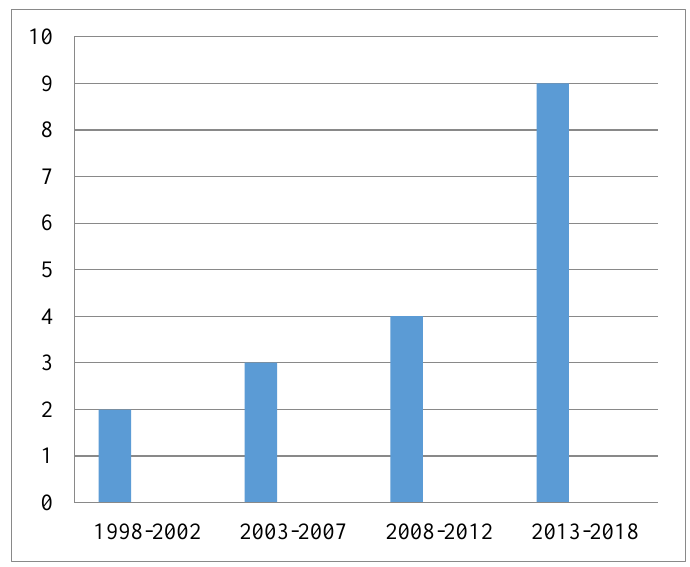
Figure 9. Period of 18 papers that showed the agreement about factors affecting MCPs. “Source: Authors”